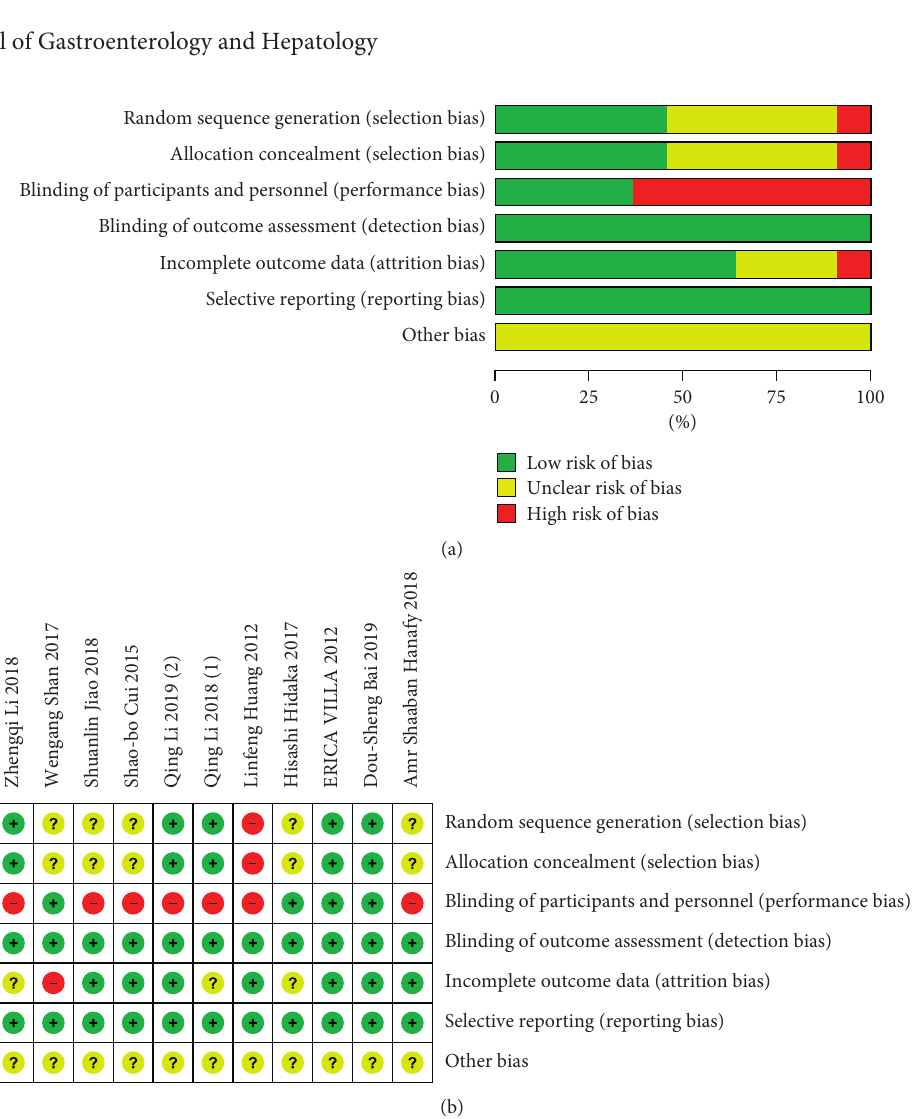
Figure 2: Bias analysis: (a) A review of the authors’ judgments about each risk of bias item presented as percentages; (b) A review of the authors’ judgments about each risk of bias item for included